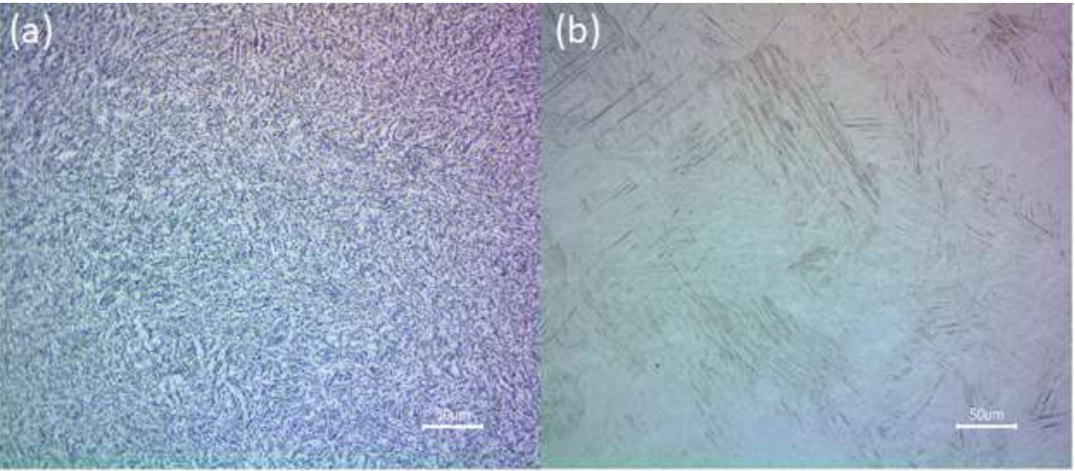
Figure 15. Optical micrographs of ( a ) Wrought Ti-6Al-4V and ( b ) DMLS Ti-6Al-4V.